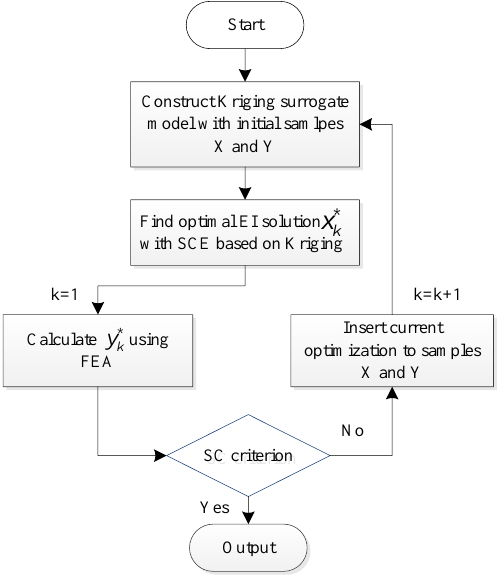
Figure 6. Optimization process.